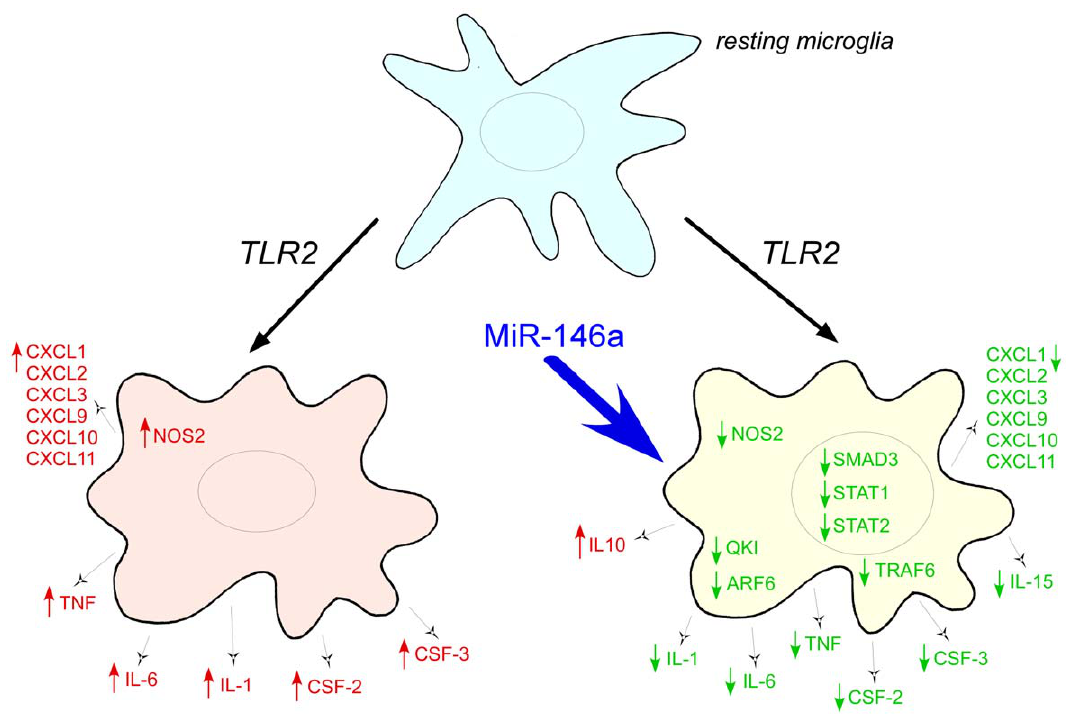
Figure 8. A summary showing key inflammatory response-related genes whose expression is modulated upon the over-expression of miR-146a.